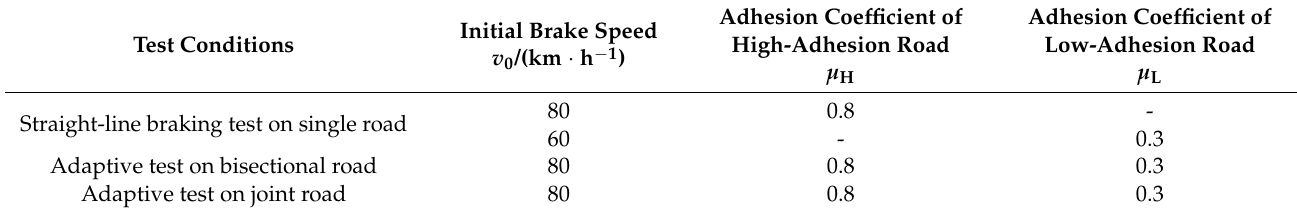
Table 4. Recommended test conditions and parameters.